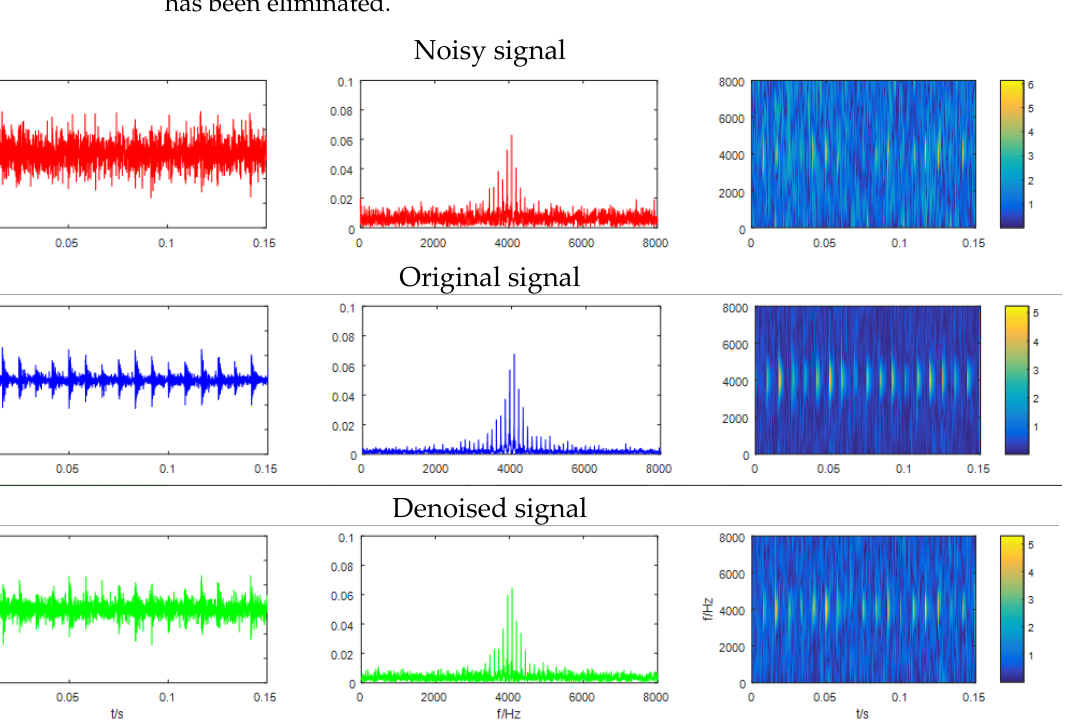
The waveform, spectrogram and frequency plot of original vibration signal, the noise added vibration signal (SNR = − 5 dB) and the denoised signal are shown as Figure 12. Figure 12 intuitively shows that most of the noise in the noisy signal after model learning has been eliminated.